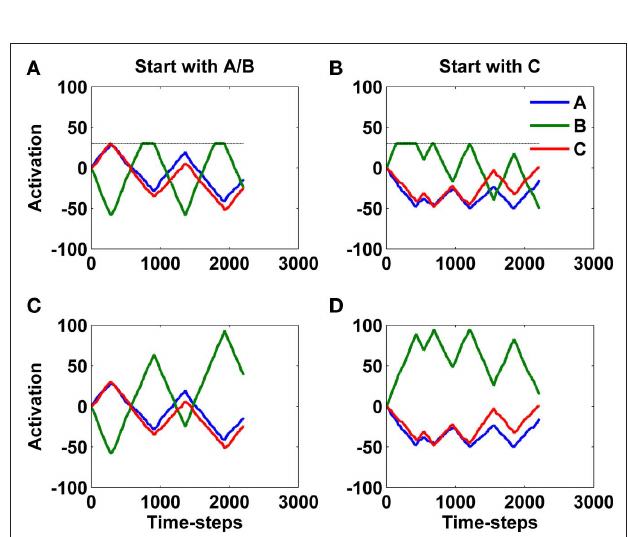
Figure A6 | Top and bottom panels have the same random seed and what changes is the existence of boundary (top panels boundary = 30, bottom infinite). The left panels show a trial in which evidence starts with A/B while the right panels show a trial which starts with C being stronger.